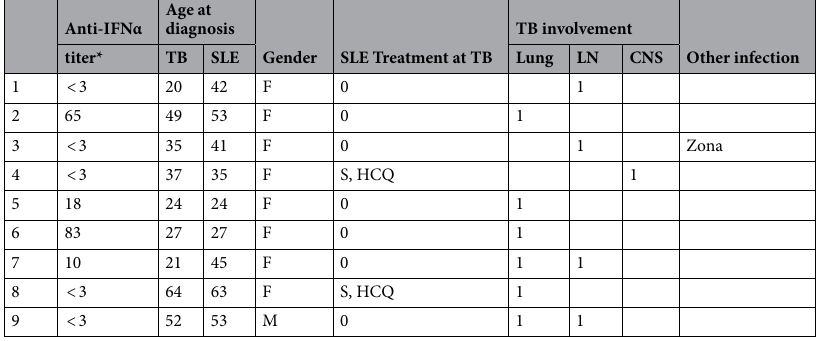
Table 2. SLE patients, anti-IFNα autoantibodies and tuberculosis. S steroids, HCQ hydroxychloroquine, LN lymph node, CNS central nervous system, F , female, M male, TB tuberculosis, SLE systemic lupus erythematosus. *Positivity threshold ≥ 10